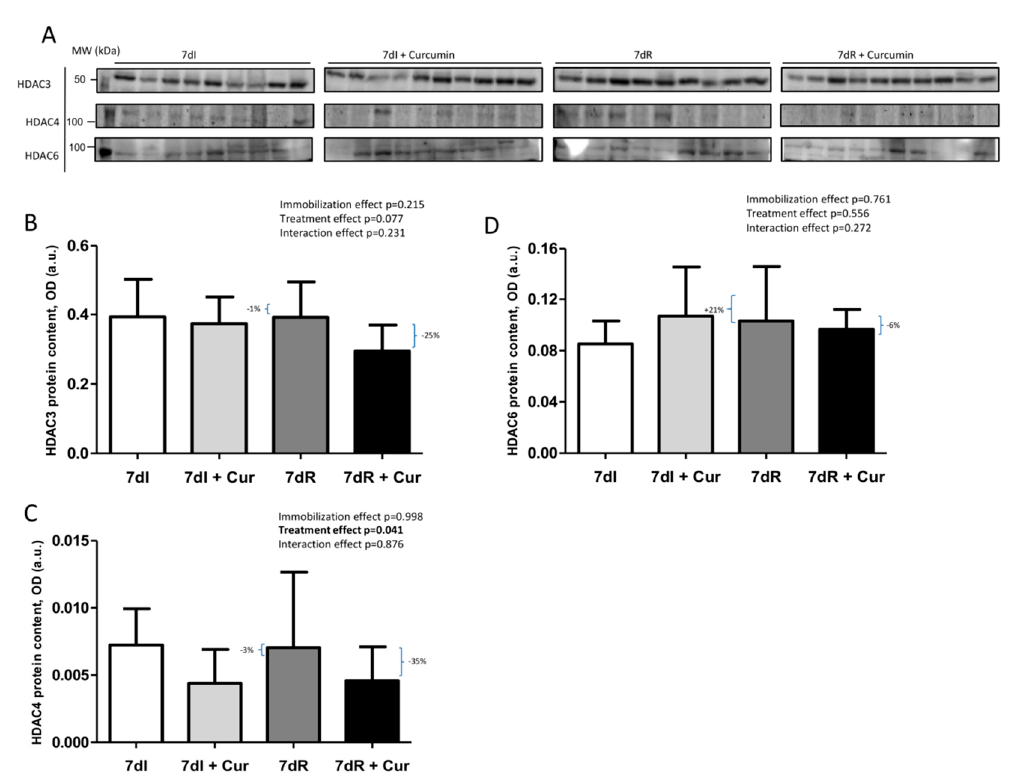
Figure 9. ( A ) Representative immunoblots of HDAC3, HDAC4 and HDAC6 proteins in the gastrocnemius muscle of all study groups of mice. Definition of abbreviations: HDAC3, histone deacetylase 3; HDAC4, histone deacetylase 3; HDAC6, histone deacetylase 6; MW, molecular weight; kDa, kilodalton; I, immobilization; R, recovery. ( B ) Mean values and standard deviation of HDAC3 protein content in the gastrocnemius muscle of the different study groups of mice, as measured by optical densities in arbitrary units (OD, a.u.). Definition of abbreviations: HDAC3, Histone deacetylase 3; OD, optical densities; a.u., arbitrary units; I, immobilization; R, recovery; Cur, curcumin. The statistical analyses (two-way ANOVA test) of the effect of immobilization, treatment and interaction effects, are also indicated as actual P values for each variable. The percentage of change between: 1) 7dR and 7dI and 2) 7dR + Curcumin and 7dR are also indicated for each variable. ( C ) Mean values and standard deviation of HDAC4 protein content in the gastrocnemius muscle of the different study groups of mice, as measured by optical densities in arbitrary units (OD, a.u.). Definition of abbreviations: HDAC4, Histone deacetylase 4; OD, optical densities; a.u., arbitrary units; I, immobilization; R, recovery; Cur, curcumin. The statistical analyses (two-way ANOVA test) of the effect of immobilization, treatment and interaction effects, are also indicated as actual P values for each variable. The percentage of change between: 1) 7dR and 7dI and 2) 7dR + Curcumin and 7dR are also indicated for each variable. ( D ) Mean values and standard deviation of HDAC6 protein content in the gastrocnemius muscle of the different study groups of mice, as measured by optical densities in arbitrary units (OD, a.u.). Definition of abbreviations: HDAC6, Histone deacetylase 6; OD, optical densities; a.u., arbitrary units; I, immobilization; R, recovery; Cur, curcumin. The statistical analyses (two-way ANOVA test) of the effect of immobilization, treatment and interaction effects, are also indicated as actual P values for each variable. The percentage of change between: 1) 7dR and 7dI and 2) 7dR + Curcumin and 7dR are also indicated for each variable.